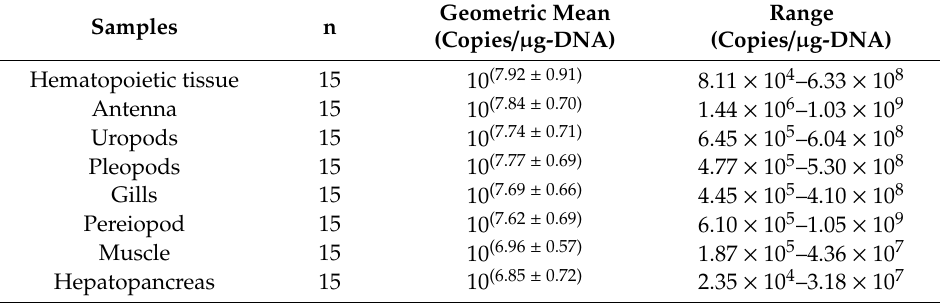
Table 2. DIV1 copies in di ff erent tissues detected in DIV1-positive prawns Macrobrachium rosenbergii